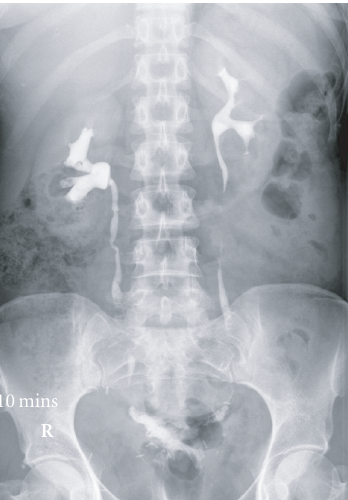
Figure 1: Intravenous urogram showing bilateral ureterovaginal fistula and significant quantities of gas within both